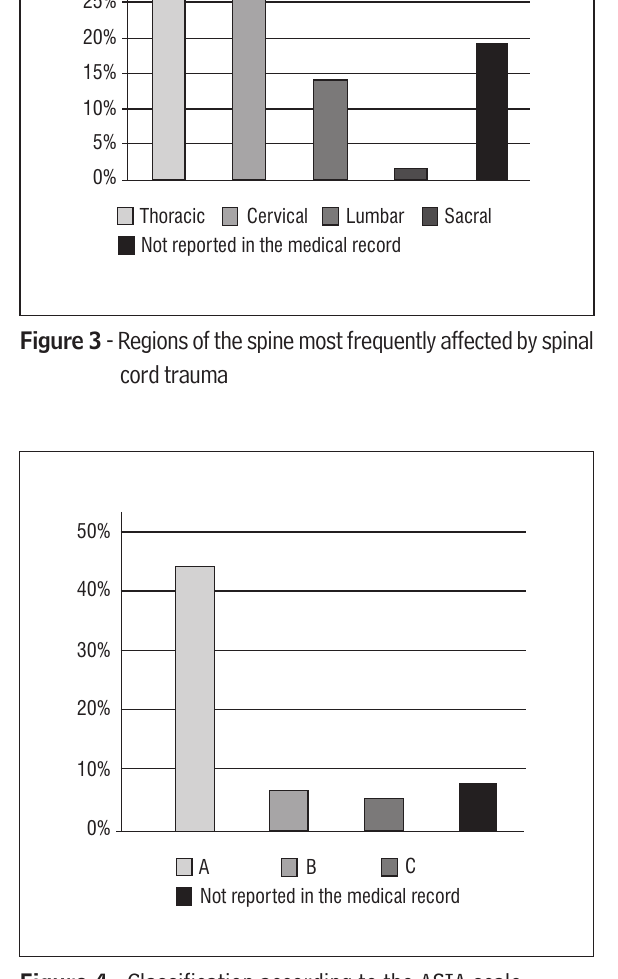
Figure 4 - Classification according to the ASIA scale